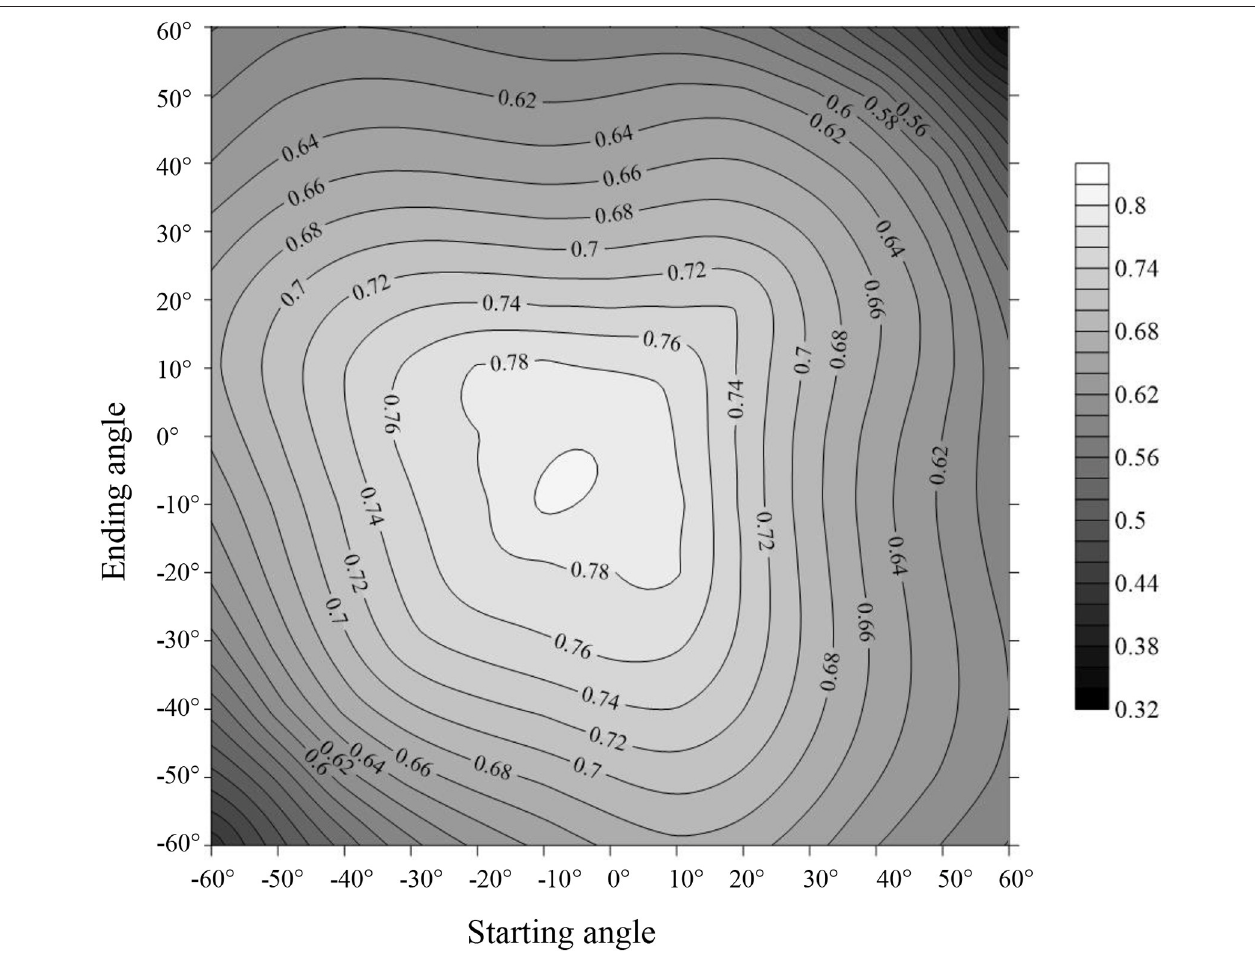
FIGURE 10 | Comparison of the predictive ability ( R 2 ) of the indices within different view zenith angles combinations in terms of aerial N